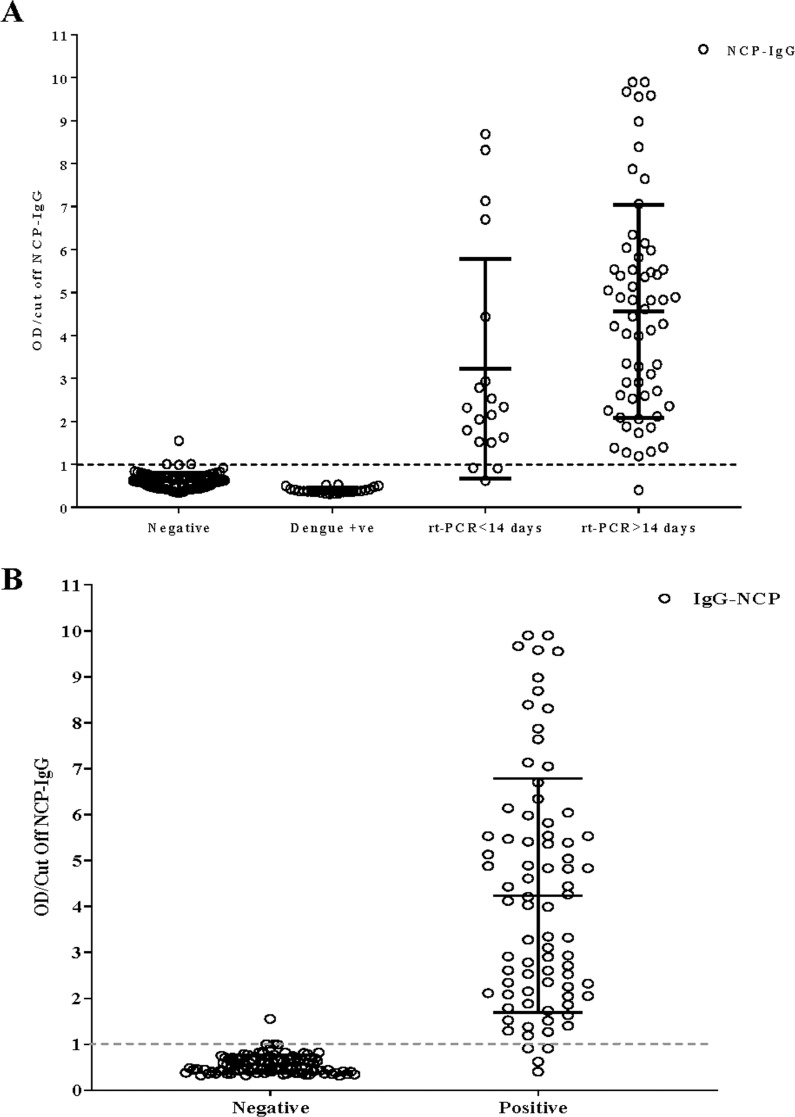
Detection of SARS-CoV2 nucleocapsid IgG among healthy donors, dengue positive samples, and SARS-CoV2 confirmed patients.Ratio of OD/cut off NCP-IgG value of negative, dengue positive and positive with SARS-CoV-2 (A) and all negative and positive cases (B) were shown. Data are presented as mean with ± Standard deviation. The reference line indicating the cut off of the in-house ELISA methods.